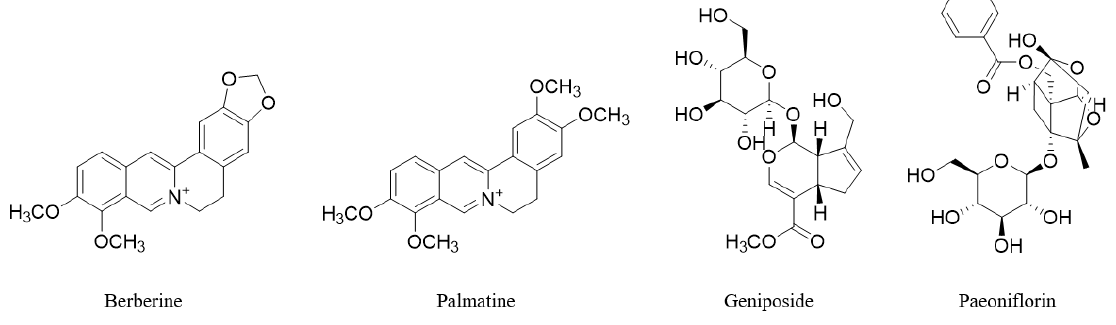
Figure 1. Chemical structures of standard compounds.